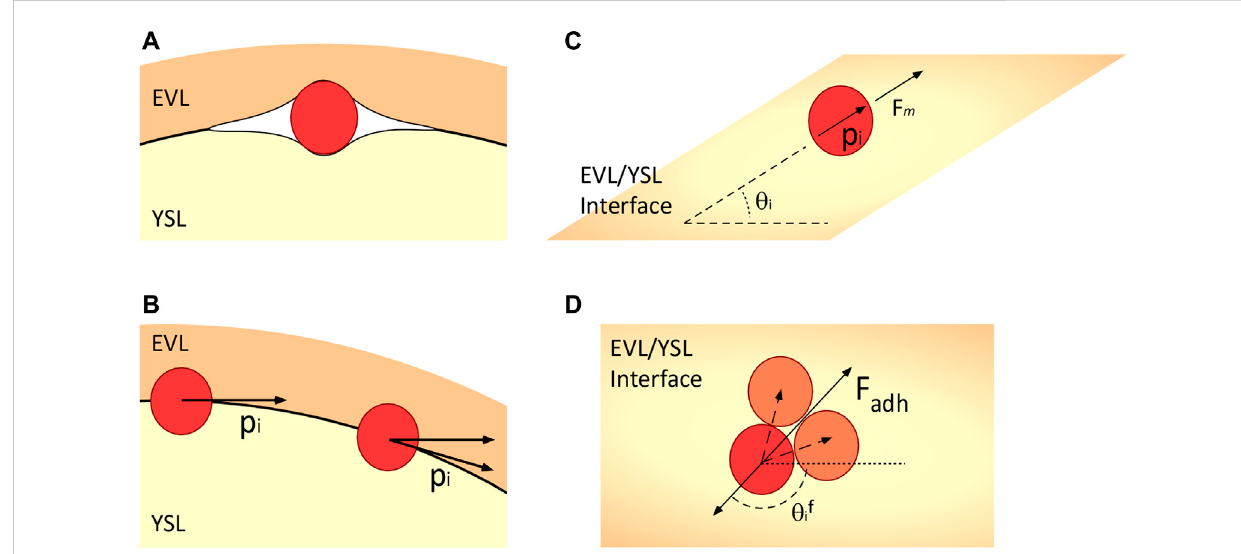
FIGURE 2 Schematic representation of the model ’ s major components. (A) Embryonic cells move between the EVL and the YSL, which are roughly spherical. Theyaresubjecttoforcesduetothedeformationoftheadjacentcelllayers. (B) Polarityofthecellsisconstrainedtothetangentialplaneastheymove. (C) Contactinhibitionoflocomotionrepolarizescellsawayfromtheaveragepositionoftheirneighbors,andadhesionforcesattractthemtotheirneighbors. (D) Anglewithrespecttotheaverageneighborposition.Thedashedvectorsindicatethedirectionstotheneighborsoftheredcell,thebottomsolid arrow indicates the reference direction, and θ f i is the angle to which the cells repolarize due to CIL. The direction of the adhesion force is shown for